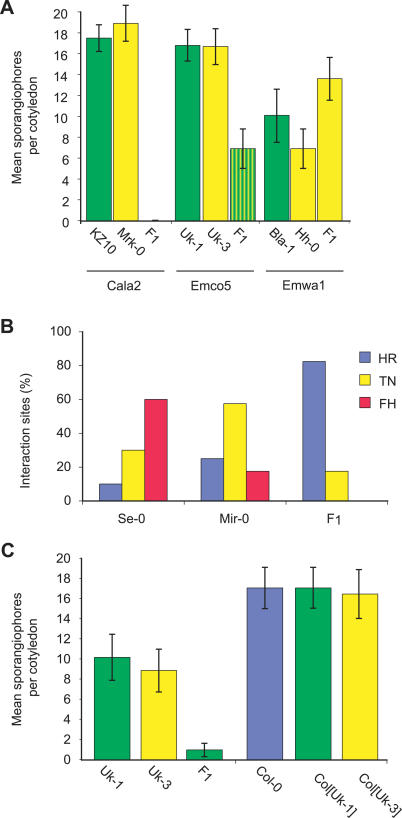
Susceptibility of Hybrids and Parental Accessions to H. parasitica Infection(A) Number of H. parasitica sporangiophores, scored 5 d (KZ10/Mrk-0, Uk-1/Uk-3, and Se-0/Hh-0) or 6 d (Bla-1/Hh-0) post-infection. H. parasitica strains used are indicated on the bottom.(B) Resistance and disease progression in Mir-0, Se-0, and their F1 hybrids. Since H. parasitica Noco2 sporulated only weakly on the parents, resistance was assessed by scoring interaction sites (Figure S2). HR sites indicate resistance, free hyphae sites (FH) indicate susceptibility, and trailing necrosis sites (TN) indicate an intermediate response.(C) H. parasitica Emco5 infection of Uk-1, Uk-3, their F1 hybrid, Col-0, and two Col-0 backcross lines. Col[Uk-1] carries the DM2 region from Uk-1 on Chromosome 3, while Col[Uk-3] carries the DM1 region from Uk-3 on Chromosome 5.Error bars in (A) and (C) indicate 95% confidence interval. All experiments were performed at least twice.